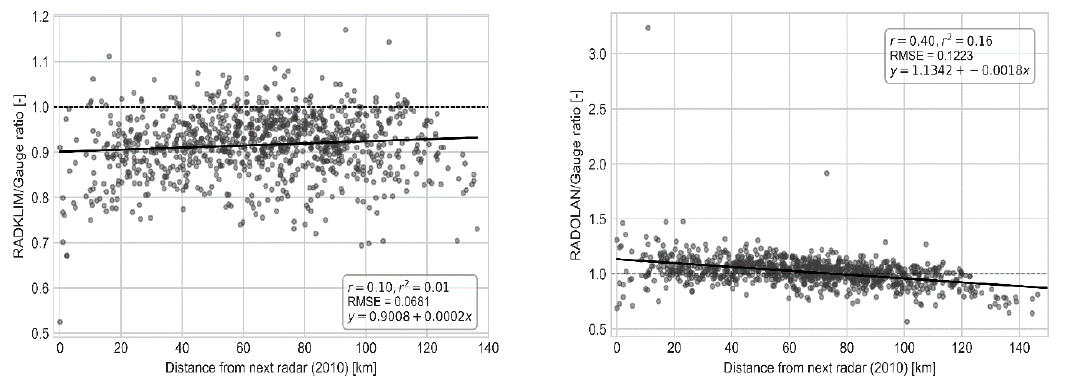
Figure 8. Linear regression between the distance from the next radar and the RADKLIM/gauge MAP ratio ( left plot ) as well as the RADOLAN/gauge MAP ratio ( right plot ).